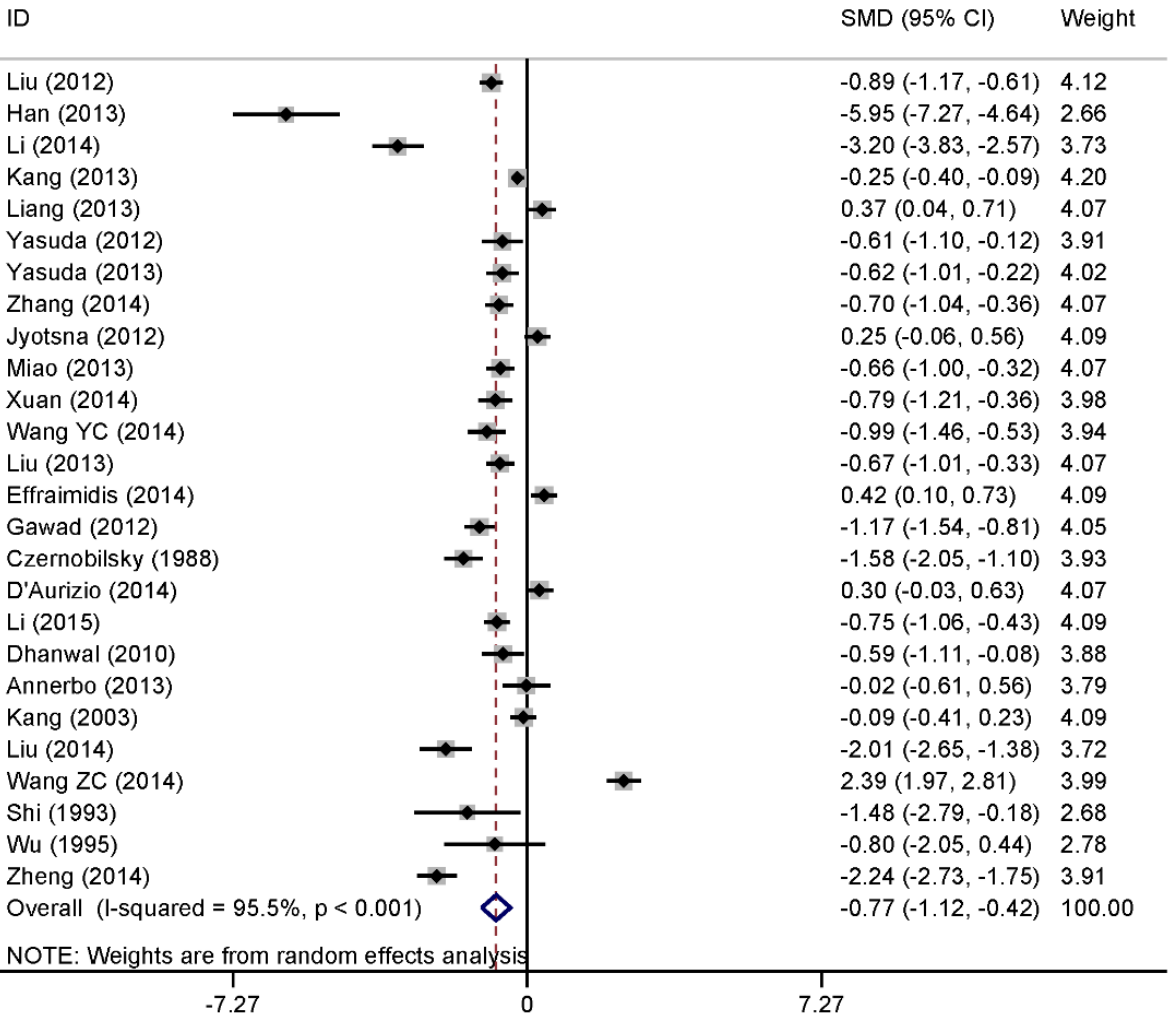
Figure 2. Forest plot of the studies comparing the association between vitamin D levels and Graves’ disease by meta-analysis with the random effects analysis. SMD, standardized mean